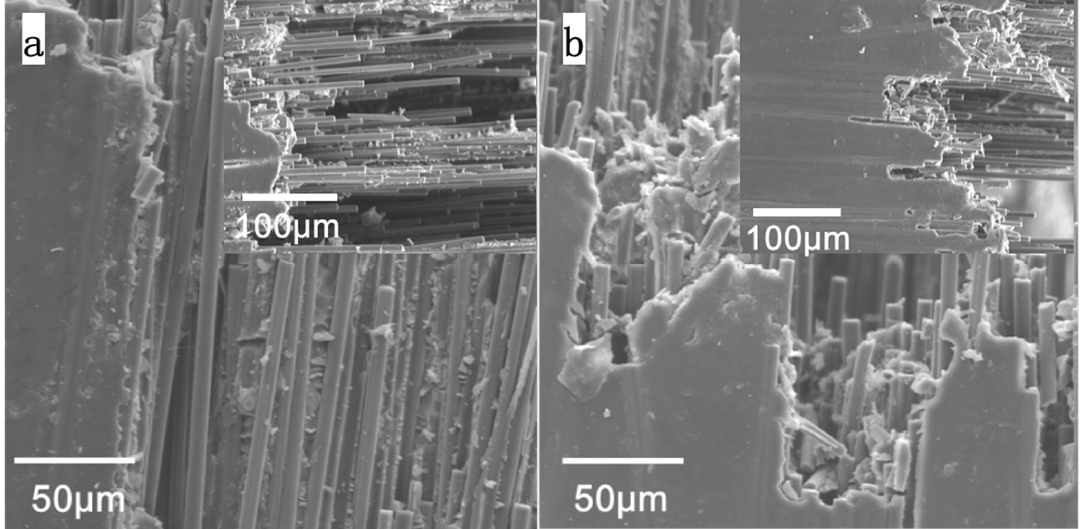
Figure 8. SEM images of fracture surfaces of CFRE samples. ( a ) Original sample, and ( b ) the sample after electrothermal treatment.